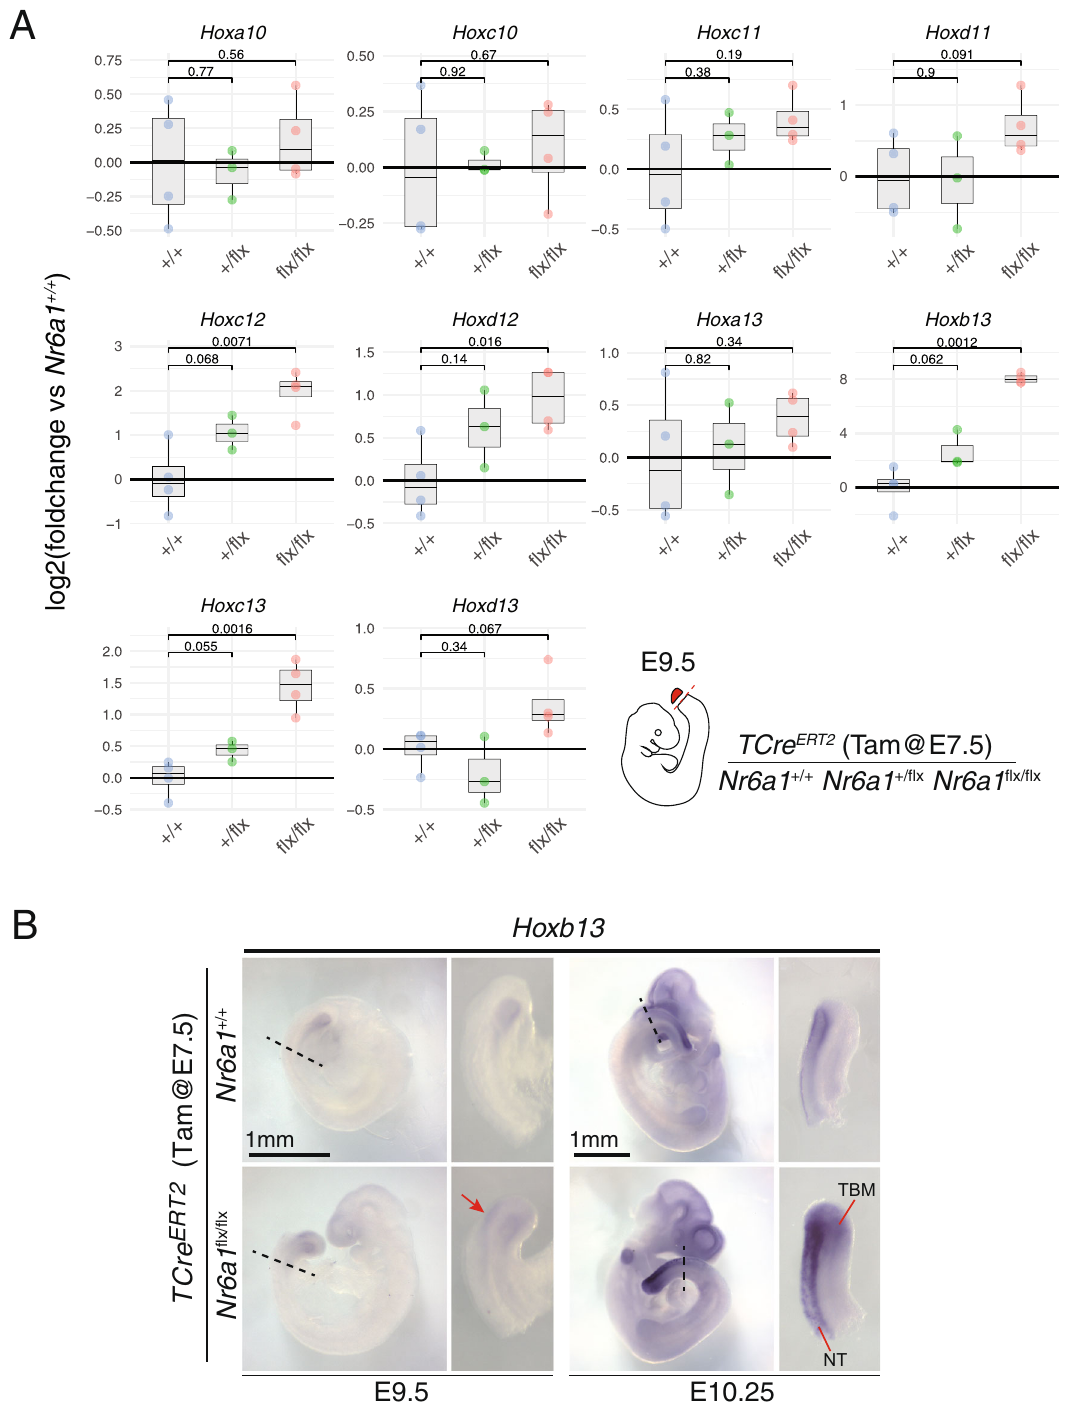
Fig. 4 | Nr6a1 suppresses posterior Hox gene expression. A Quantitative PCR analysis of posterior Hox gene expression within tailbud tissue isolated from TCre ER T2 controls, TCre ER T2 ; Nr6a1 +/ fl x and TCre ER T2 ; Nr6a1 f lx/ fl x embryos at E9.5, n =3 biologically independent samples per genotype. Statistical analysis of differences between genotypes was performed using an unpaired two-sample Welch ’ s t test,